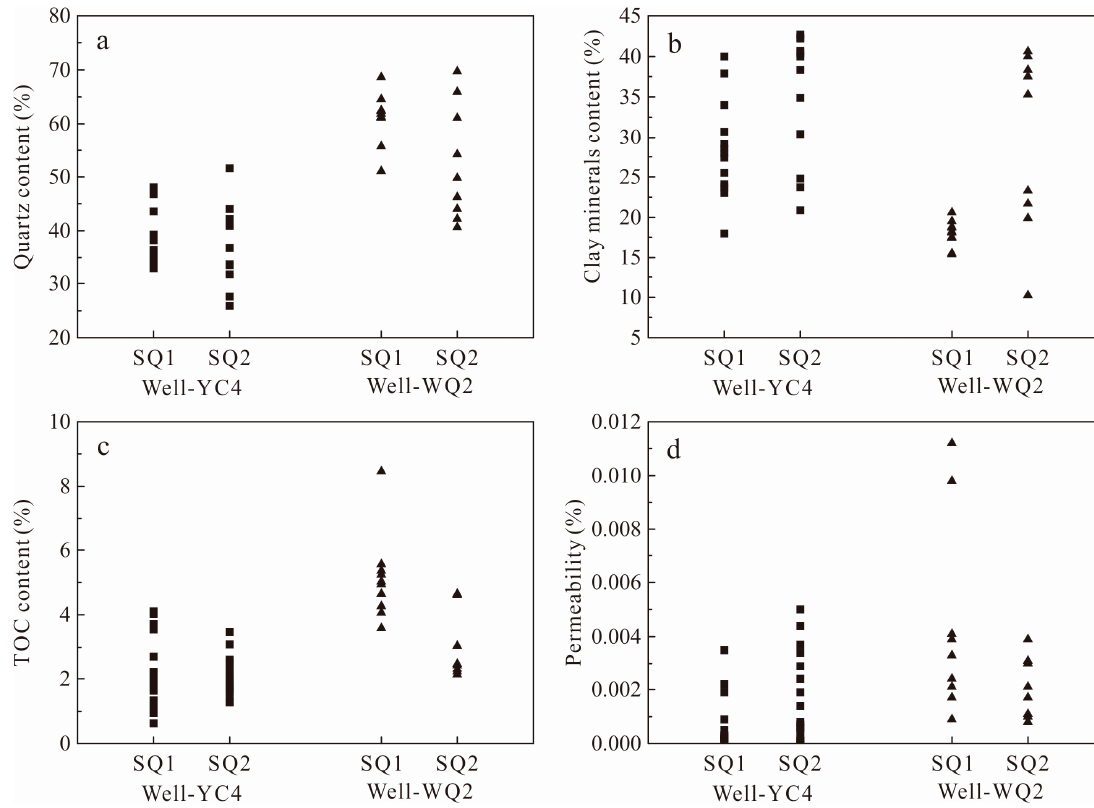
Figure 11. The comparisons of ( a ) quartz content, ( b ) clay minerals content, ( c ) TOC content and ( d ) permeability for LSL shale between the study well and Well-YC4 from the southeastern Sichuan Basin. The data of Well-YC4 is referenced from Xiong et al. [8]. The location of Well-YC4 is identified in Figure 12.